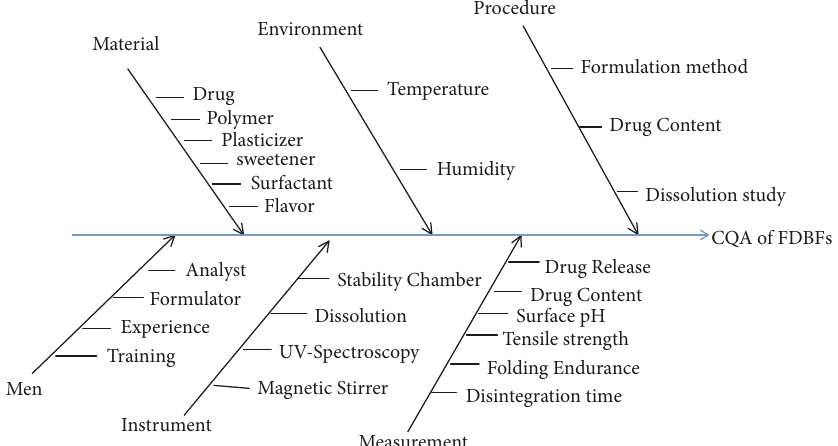
Figure 1: Ishikawa fish-bone diagram depicting the cause and effect relationship among the formulation and process variables.